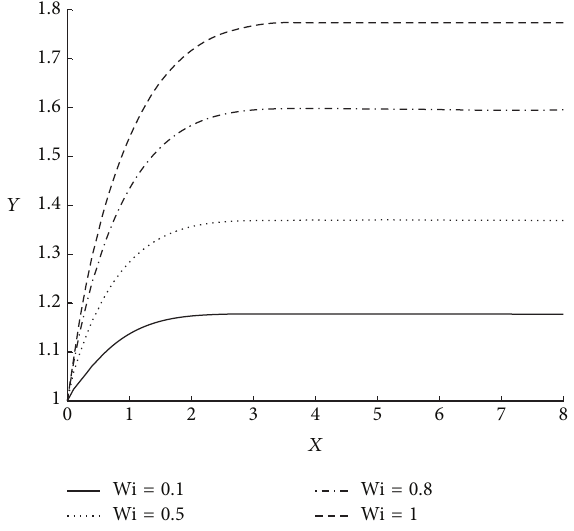
Figure 5: Free surface profile for various Wi for 𝛽 = 0.1 .